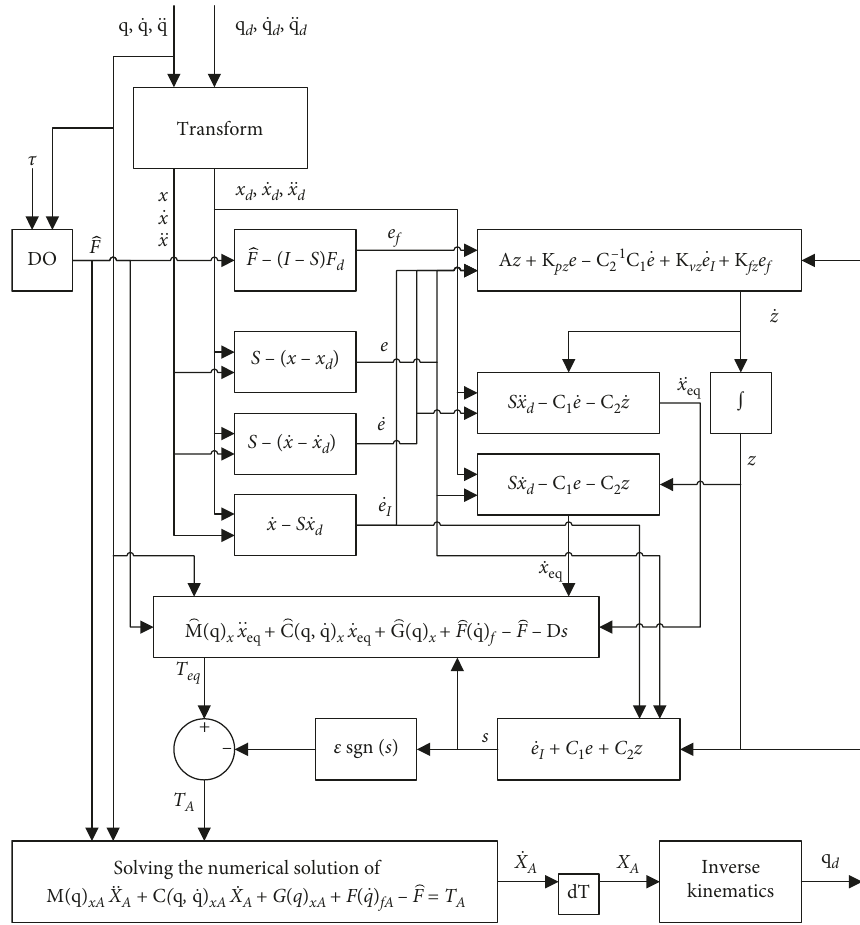
Figure 5: Hybrid sliding mode impedance controller flow